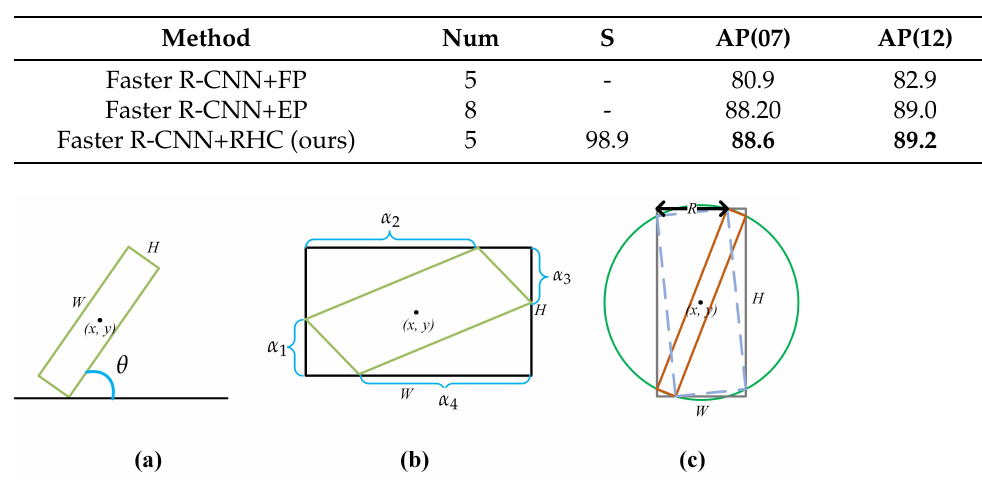
Table 1. Performance comparison of Faster R-CNN under different rotated box representations. The highest value is indicated by bold numbers (%).